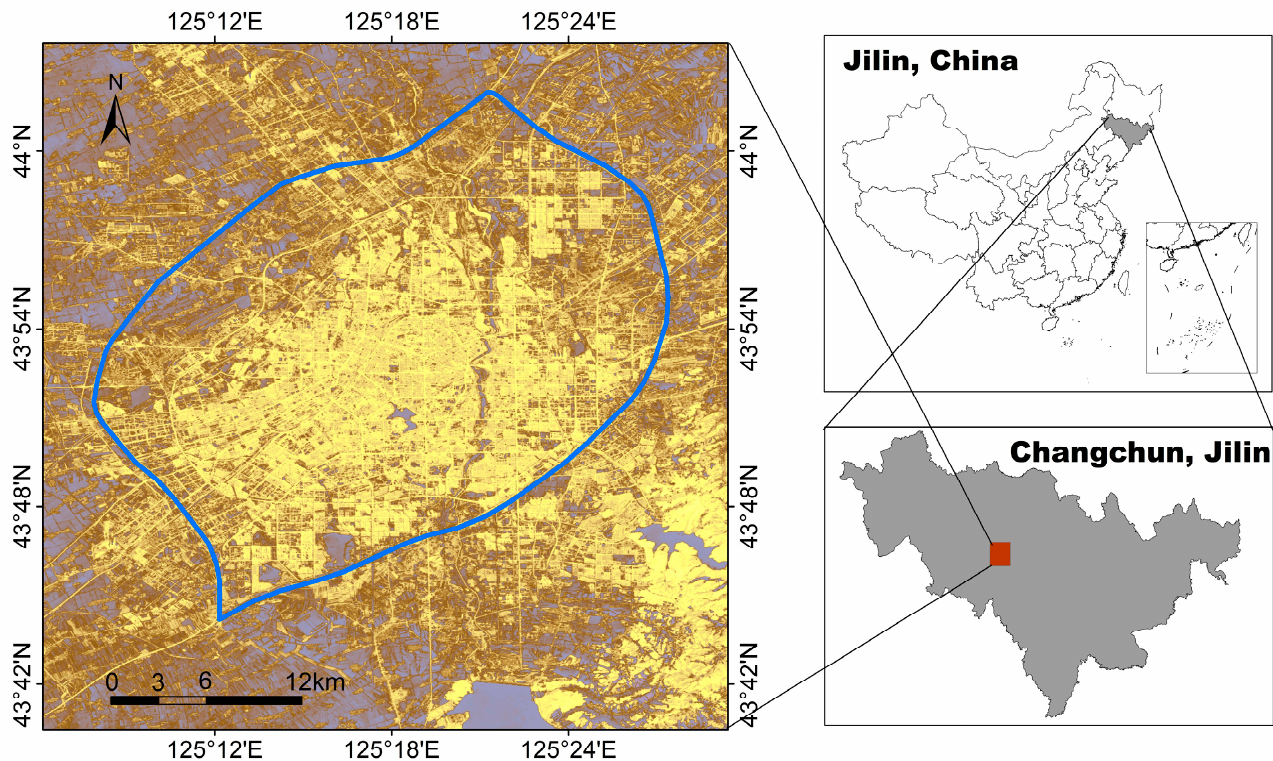
Figure 1. Location map of the study area.